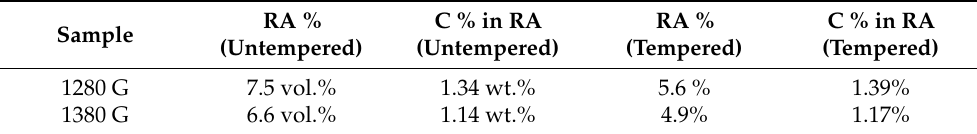
Figure 5. TEM images of microstructure in 1380 G rail steels. ( a ) bright field image showing lath bainite with inter-lath film-like retained austenite, where the inset image is the selected area electron diffraction patterns; ( b ) dark field image showing retained austenite; ( c , d ) carbide in lower bainite; ( e , f ) martensite lath and inter-lath film-like retained austenite. Table 2. Retained austenite amount (RA %) and its carbon content (C %) in the 1280 G and 1380 G rail steels before or after tempering, determined by X-ray